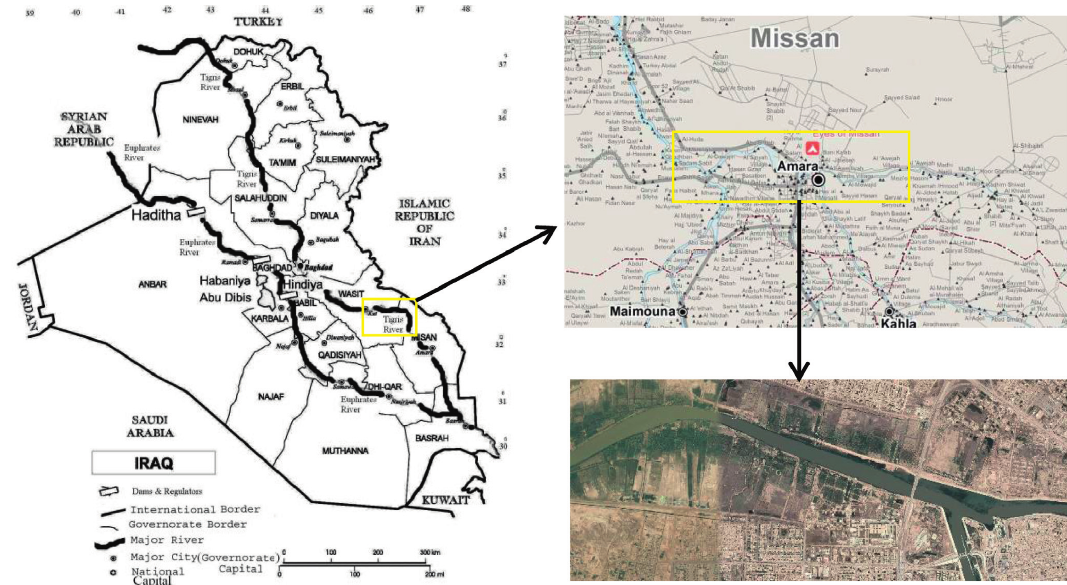
Figure 1: Location of study